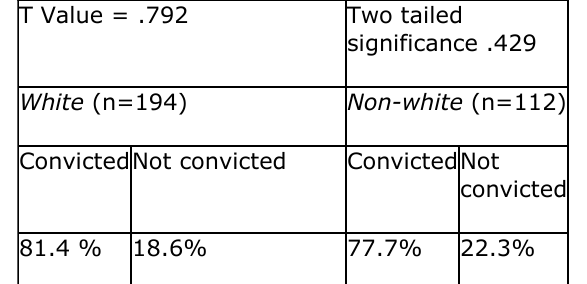
Table 3: Percentage of Celebrity Convictions by race, 1998-2010 T Value = .792